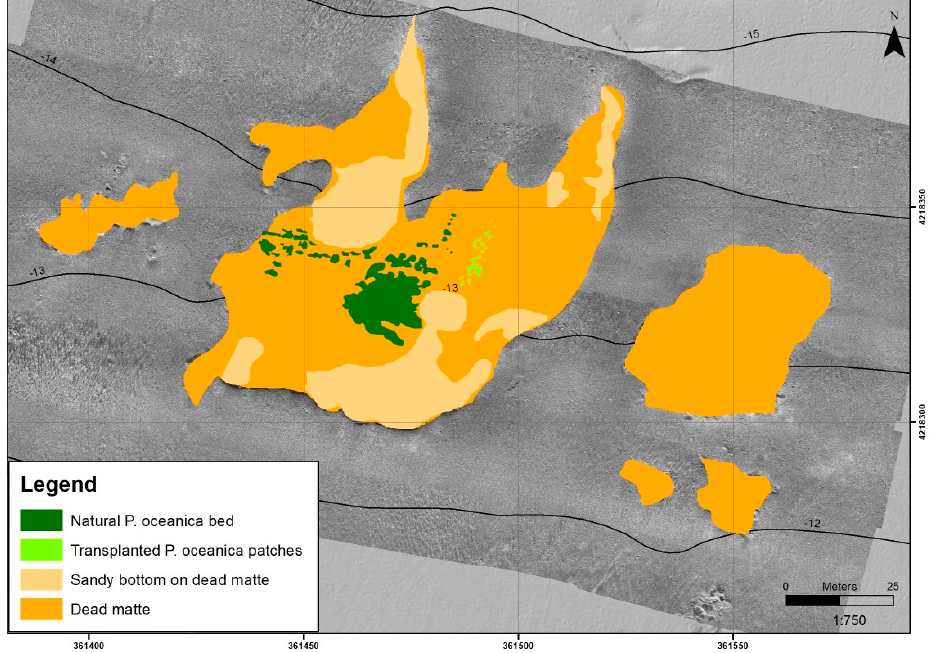
Figure 3. Distribution map of P. oceanica meadows (natural and transplanted) on dead matte sur- rounded by sandy bottoms.